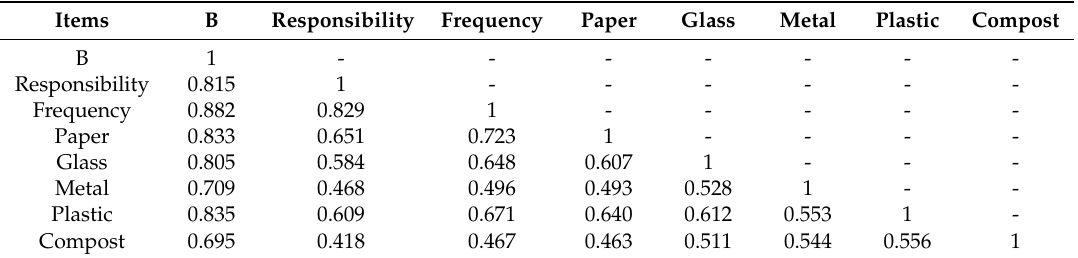
Table A2. Correlation values between items making up the recycling behavior construct.